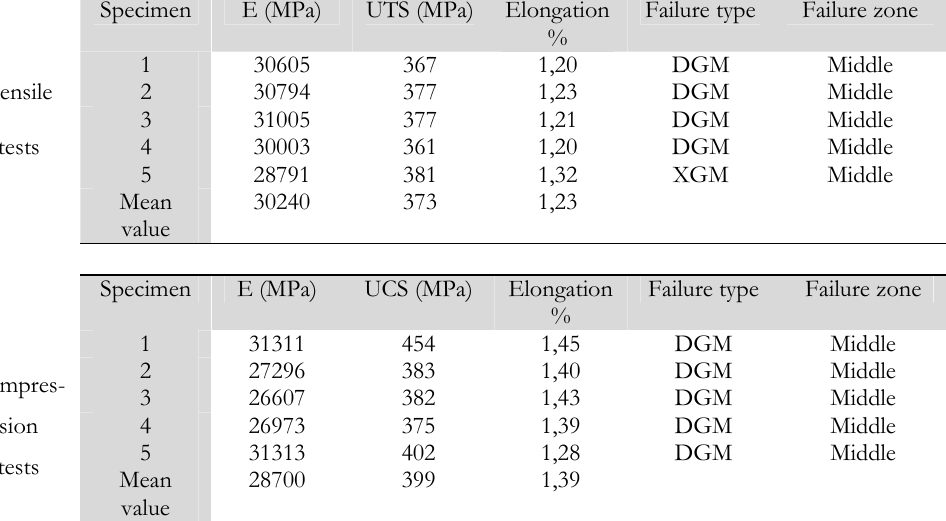
Table 2: Summary of the results of the static tests